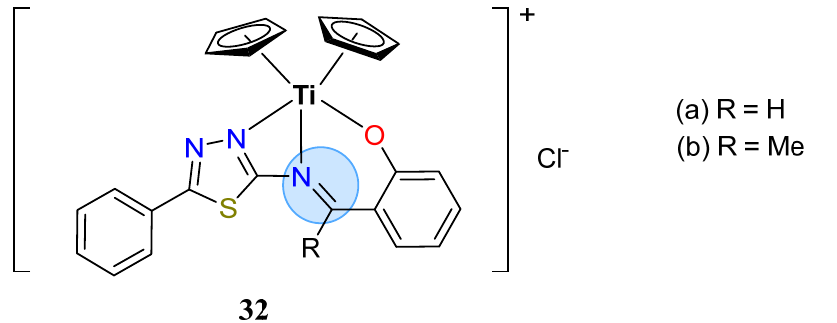
Figure 15. Bis(cyclopentadienyl)titanium(IV) derivatives with antimicrobial activity. Mononuclear complexes of Ti(III), Cr(III), Mn(III), and Fe(III) with tridentate hy- drazone ligands 2-hydroxy-5-chloroacetophenonebenzoylhydrazone and 2-hydroxy-3,5- dichloroacetophenone-4-nitrobenzoylhydrazone (Figure 16) were screened for their